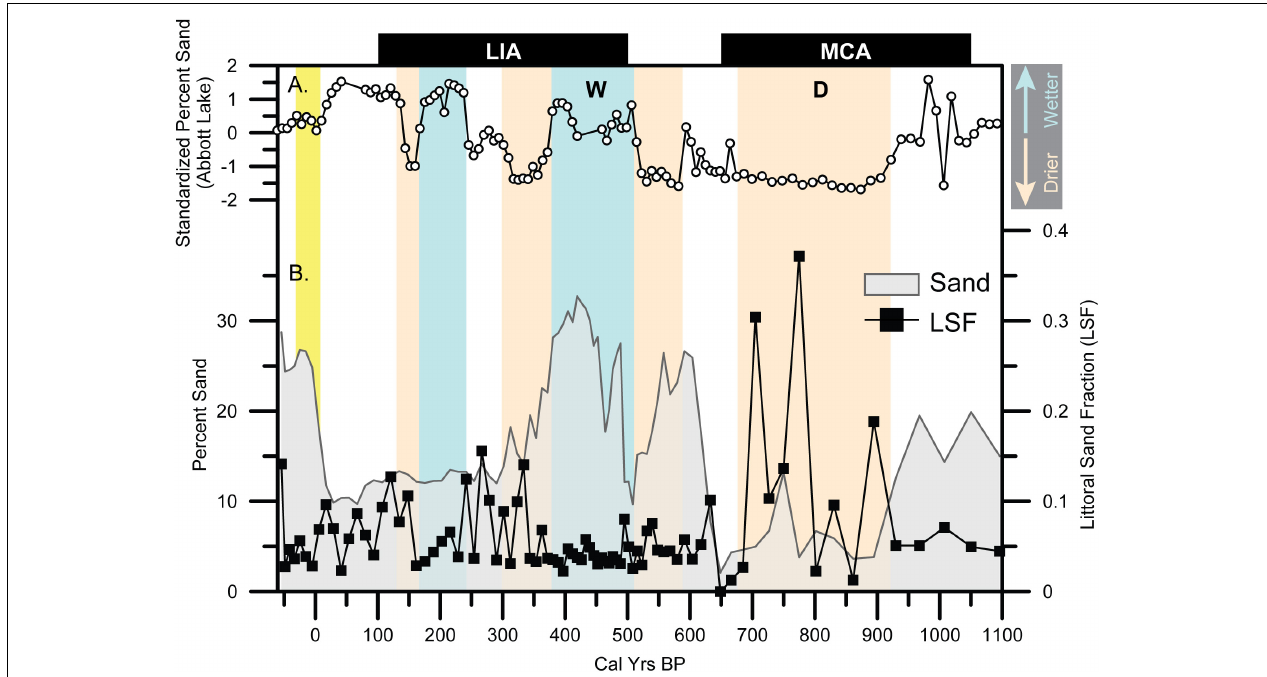
FIGURE 10 | Plot of Holocene changes in grain size characteristics versus climate variability. The time periods for the Medieval Climate Anomaly (MCA) and Little Ice Age (LIA) are shown at the top as black bars (Masson-Delmotte et al., 2013). (A) The regional climate climate periods from nearby Abbott Lake by Hiner et al. (2016) are shown as the standardized sand content (white circles) and the correponding blue and orange vertical bars. Blue bars (“W”) indicate wetter periods, while orange bars (“D”) indicate drier periods. (B) The total sand (gray area) and littoral sand fraction (black squares) for PS1410-08GC are plotted vs. time based on the composite age model. The yellow vertical bar depicts the period of maximum dam construction (Willis and Griggs, 2003).